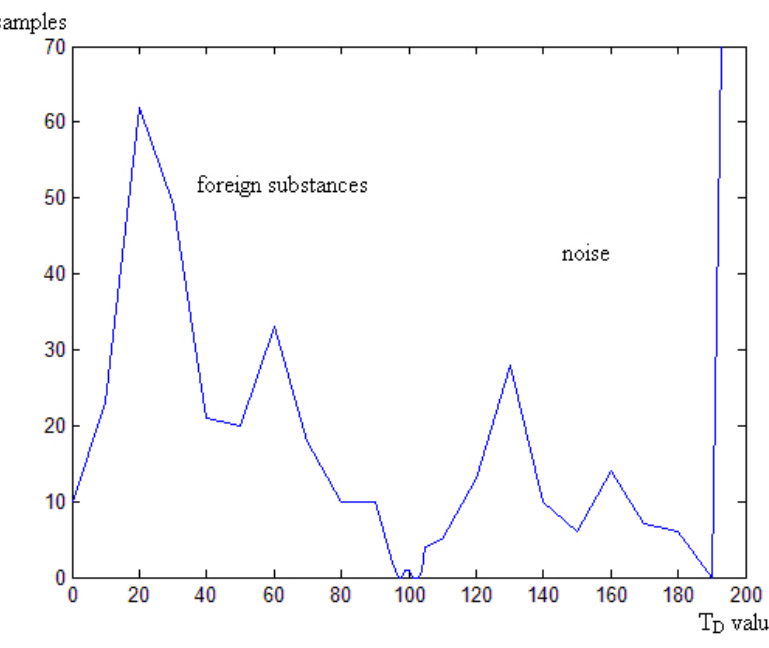
Figure 9. T values of 603 track D